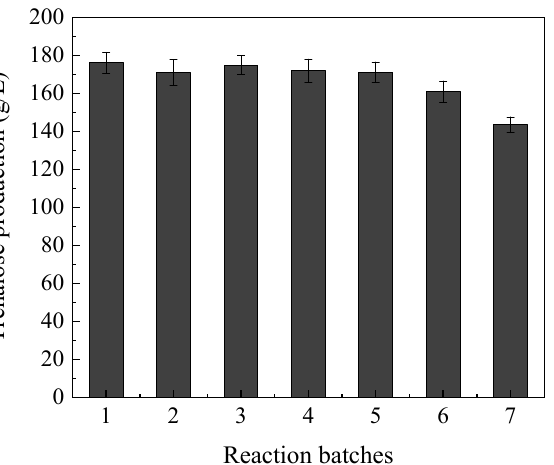
Figure 8. Repeated use of the whole-cell biocatalysts for the production of trehalose. The reaction time for every batch was 12 h. The error bars represent the standard deviation of three independent replicates.